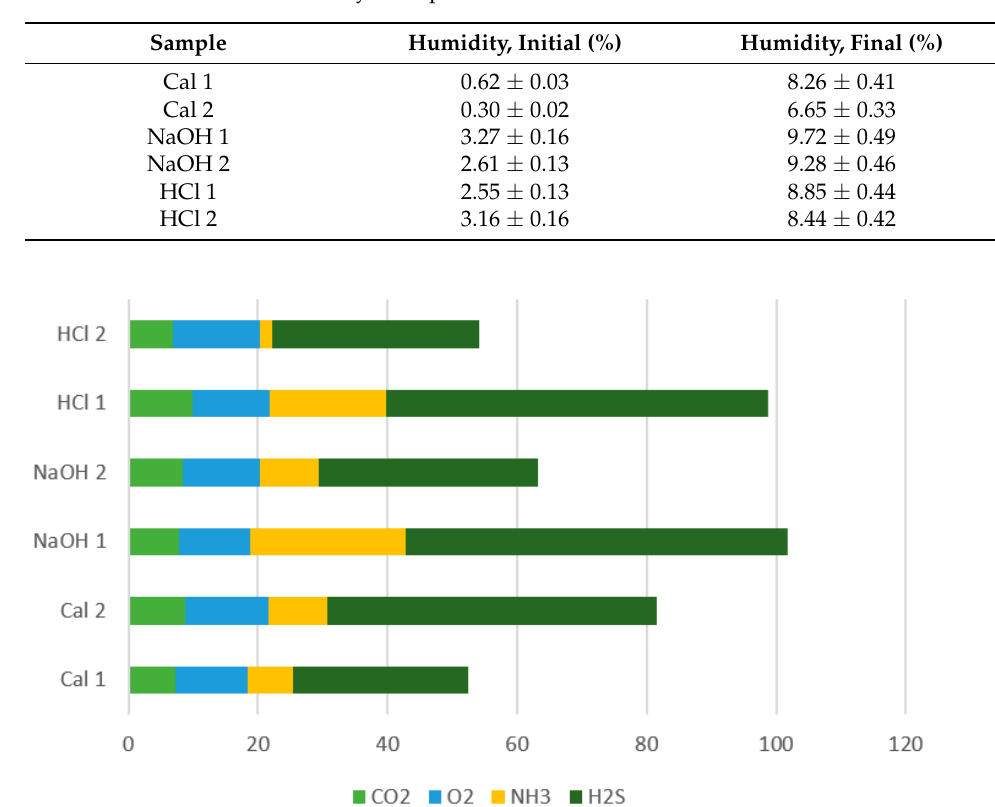
Table 5. Levels of zeolite humidity adsorption.